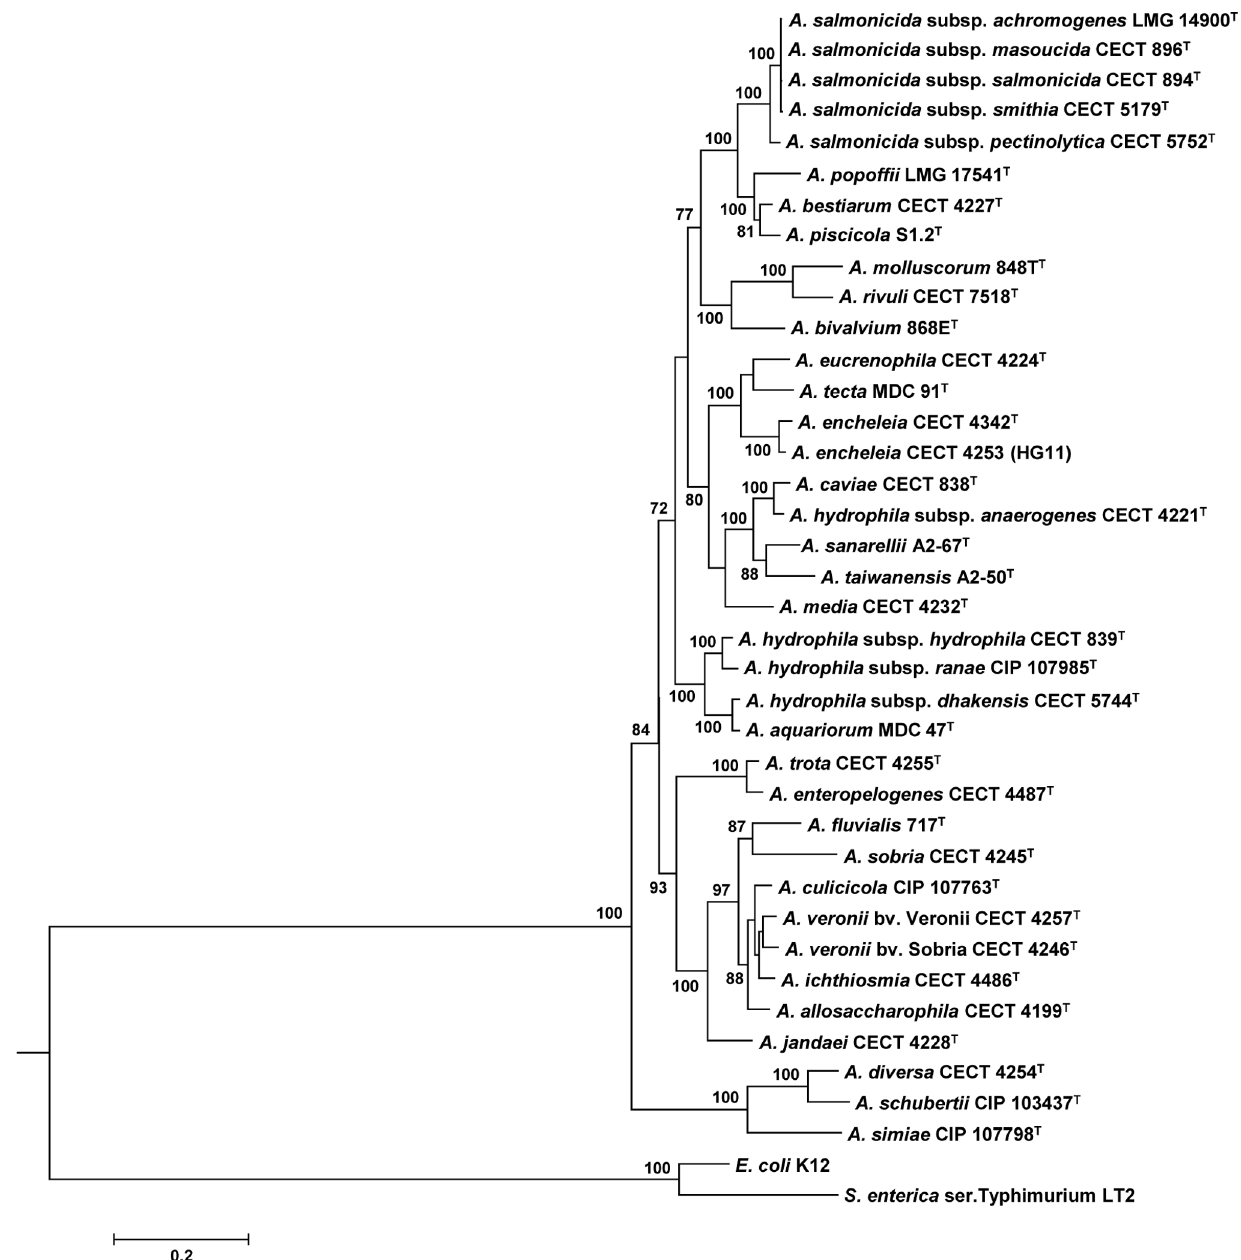
Figure 1. Aeromonas species maximum likelihood phylogenetic tree. E.coli and S. enterica were used as the outgroup. Nodes supported by bootstrap values $ 70% are indicated. The scale bar represents 20% sequence divergence.